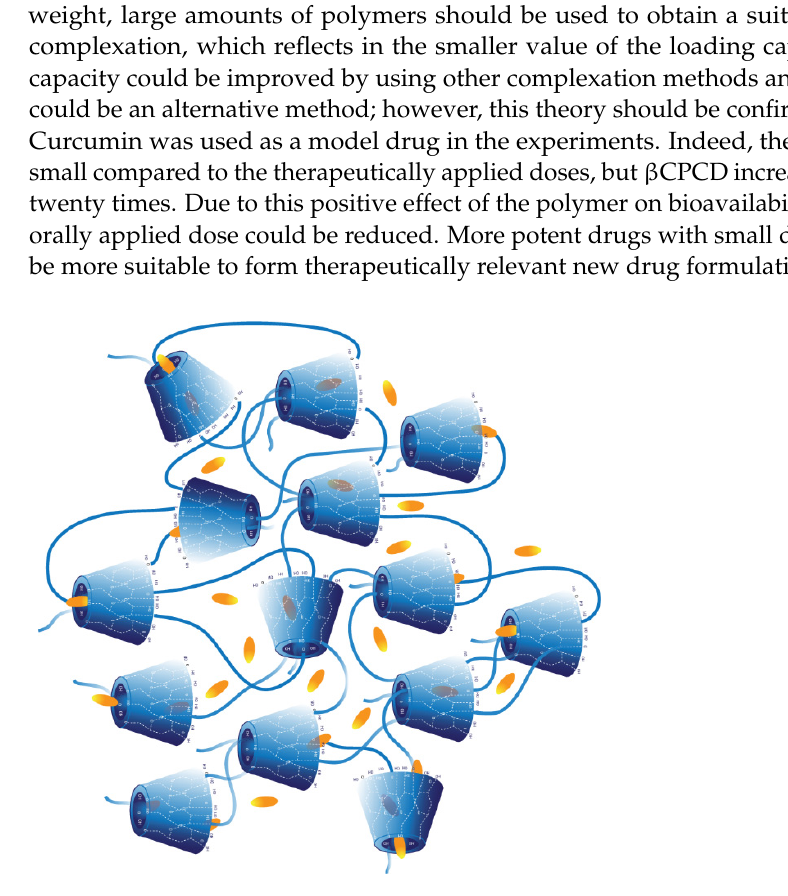
Figure 12. Schematic representation of β CPCD–curcumin complex. The yellow-colored curcumin molecules are entrapped in the β -CD cavity and in the 3D cross-linked area.